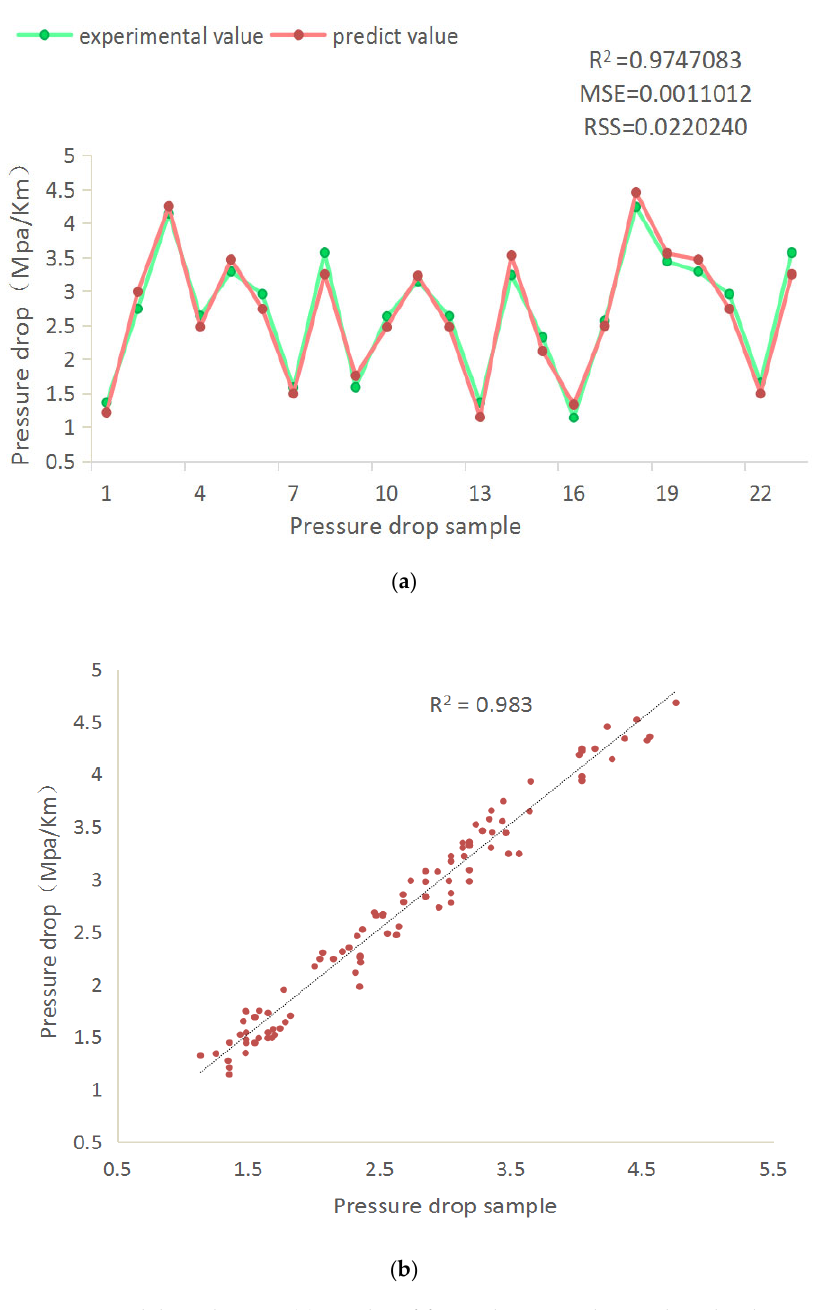
Figure 6. Model prediction: ( a ) results of fitting between the predicted values of the test set and the actual values; ( b ) results of fitting between the predicted values of the training set and the measured values.